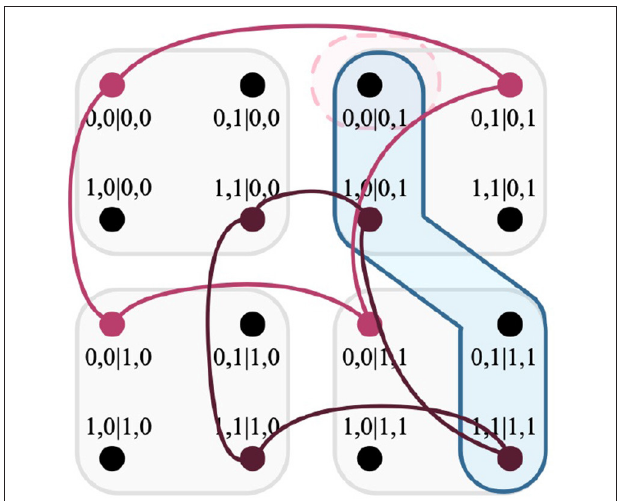
FIGURE 10 | Intersection of cliques, a hyperedge of the F-R product, and a relation. The hyperedge returned by Definition 33 is highlighted in blue; the relation r is highlighted in light red.